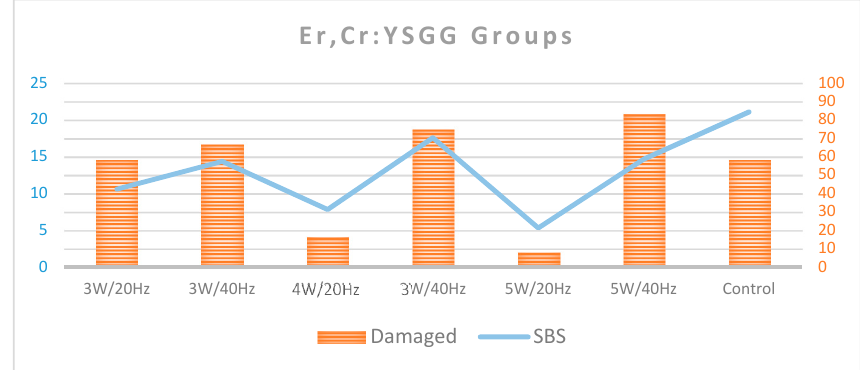
Figure 10. Summarize the mean SBS value percentages and the percentage of damaged enamel in each of the Er,Cr:YSSG groups.